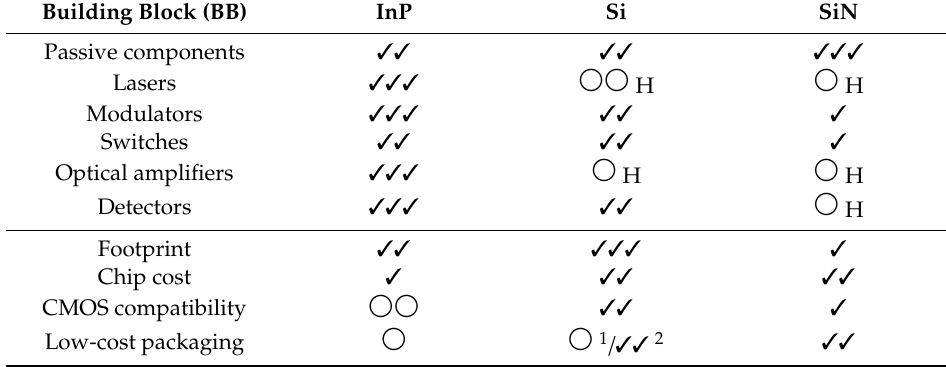
Table 1. Key features from three available photonic integration platforms, i.e., indium phosphide (InP), silicon (Si), and silicon nitride (SiN) monolithic technologies.